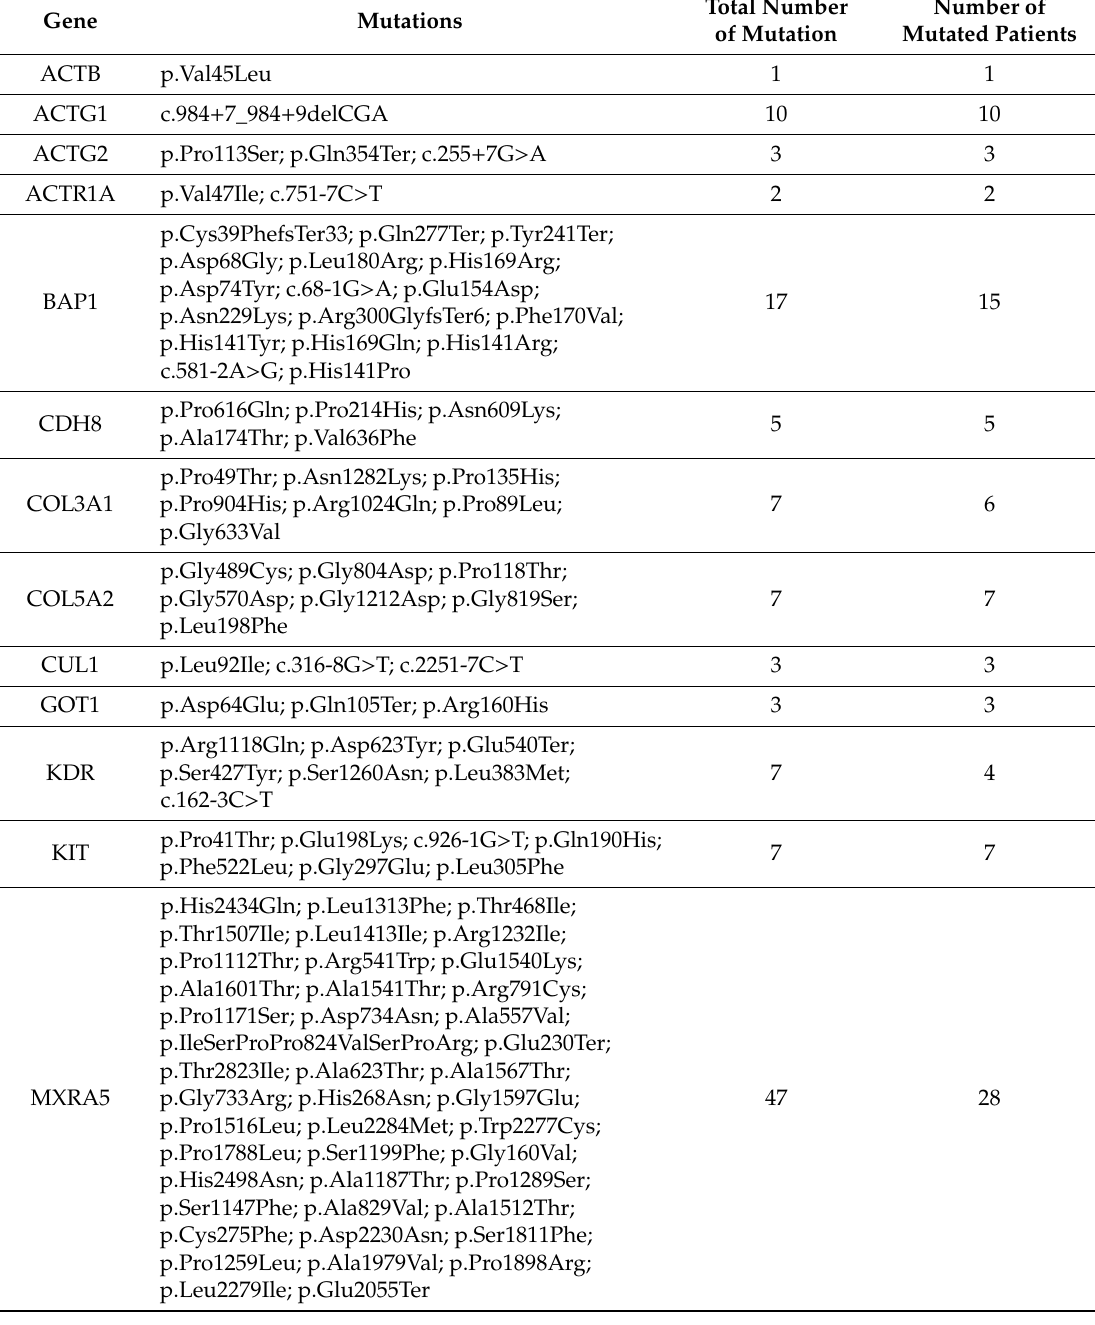
Table 1. List of mutations detected in epithelioid and biphasic MPM